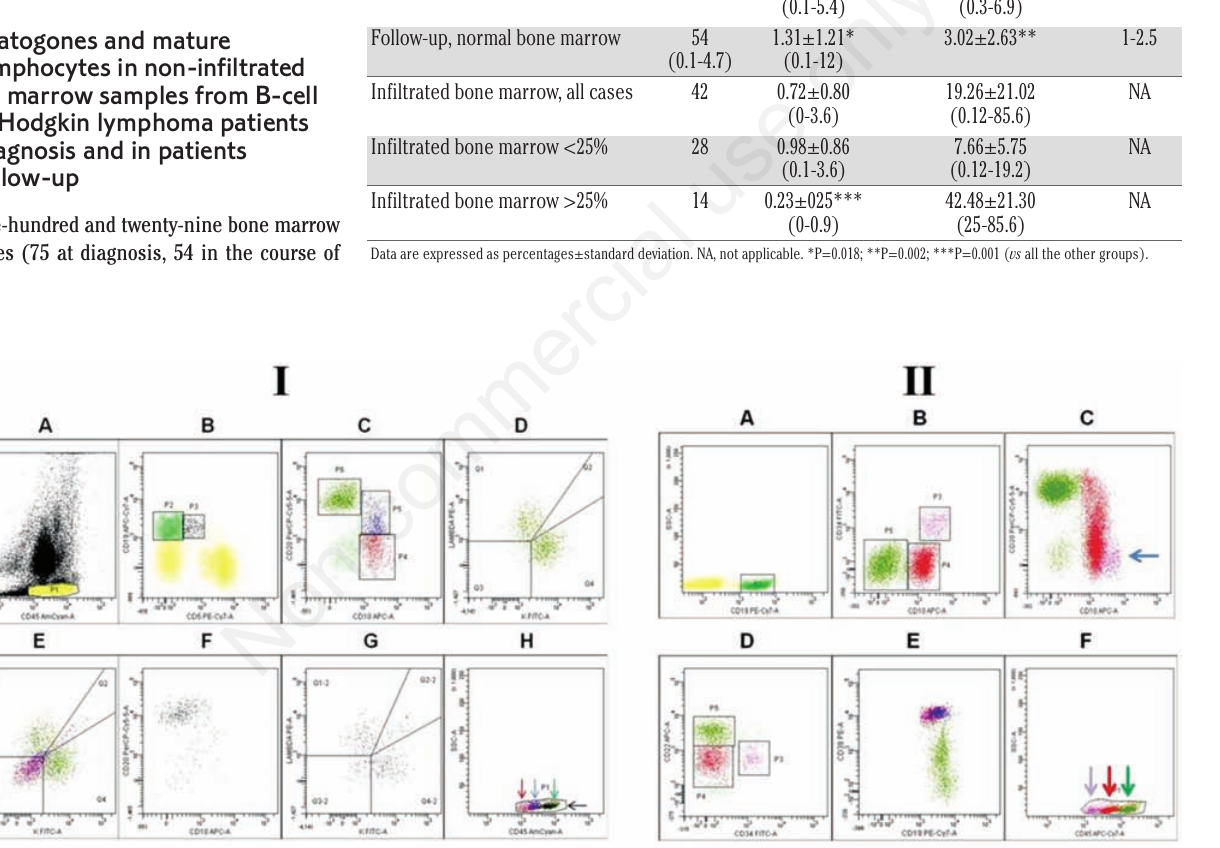
Figure 1. I: simultaneous K/ l analysis and detection of hematogones in a bone marrow sample without lymphomatous infiltration (patient with follicular lymphoma involving a single skin lesion). A) initial gate setting (P1). B) the two gates include CD5-negative B-lymphocytes (P2) and B-lymphocytes with dim expression of CD5 (P3). C) Distribution of CD5-negative B-lymphocytes in the CD10/CD20 cytogram. Hematogones (P4 plus P5) can be observed, along with mature, CD10-negative B-lymphocytes (P6). Hematogones with dim/heterogeneous CD10 expression are 30% of the whole hematogone population. D) K/ l analysis of mature B-lymphocytes, which are polyclonal (ratio: 1.6:1). E) both P4 and P5 cell populations lack surface light chains, in agreement with their relative immaturity. F) the population of CD5- positive B-lymphocytes lacks CD10, and G) is polyclonal (K/ l ratio: 1.35:1). H) CD45/SS back-gating: an increasing CD45 expression char- acterizes hematogones and mature B-lymphocytes. The CD5-positive population is localized within the gate of mature lymphocytes. The four arrows show the localization of the respective cell populations. The whole analysis shows: 2.3% mature B-lymphocytes (P3+P6, i.e. 0.8+1.5%); 1.1% hematogones (P4+P5. i.e. 0.77+0.33%). II: additional tube to complete immunophenotyping of the case described in Image I. A) B-lymphocyte gating. B) detection of type 1 HG (P3). P4 includes type 2 and type 3 HG. P5: mature B-lymphocytes. C) CD34+ hematogones show the brightest CD10 expression (arrow). D,E) different pattern of expression of CD22 (D) and CD38 (E) in HG and mature B-lymphocytes. F) back-gating of HG and mature B-lymphocytes in the CD45/SSC cytogram, as shown by the arrows.